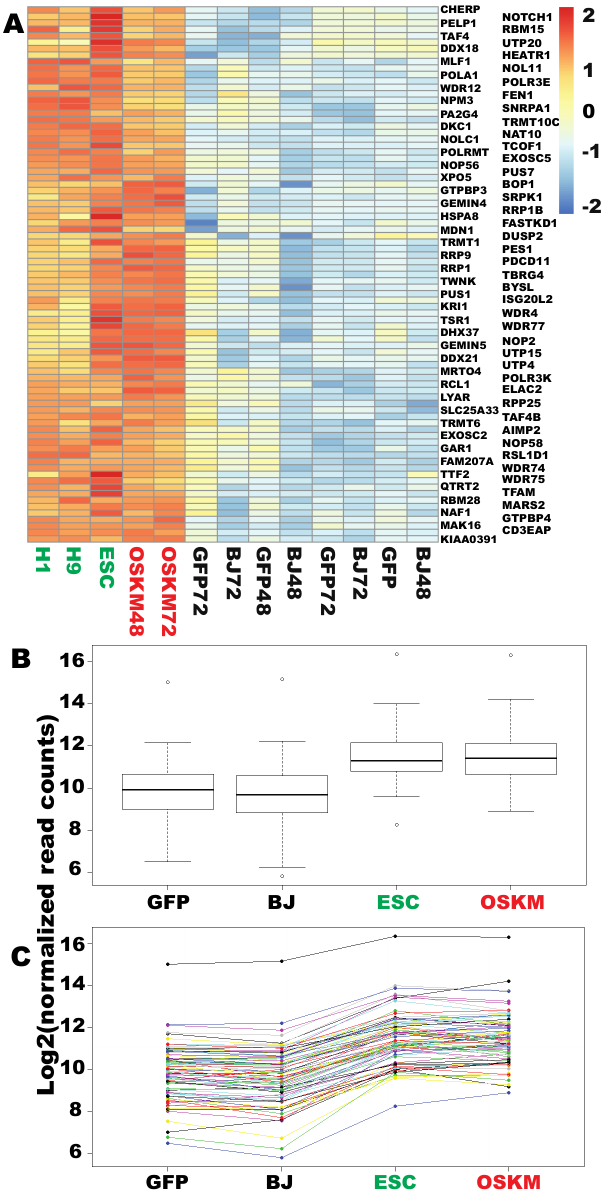
Figure 3. Eighty-three genes involved in RNA metabolisms were successfully reprogrammed within 48 h. ( A ) Heat map for the 83 reprogrammed RNA metabolism genes. ( B ) Box plot for the data in ( A ) to show overall successful reprogramming of those genes. Dots above or beneath the wiskers are outliers of each group. ( C ) ladder plot for the genes and their data in ( A ) and ( B ). Each line across the samples represent a specific gene. Figure sample labels are the same as in Figure 1.